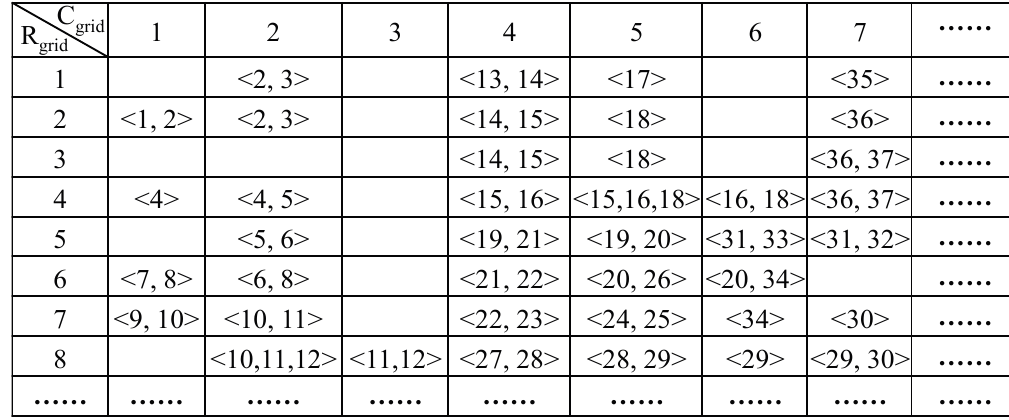
Figure 19. Established lookup table of grid points in the vector